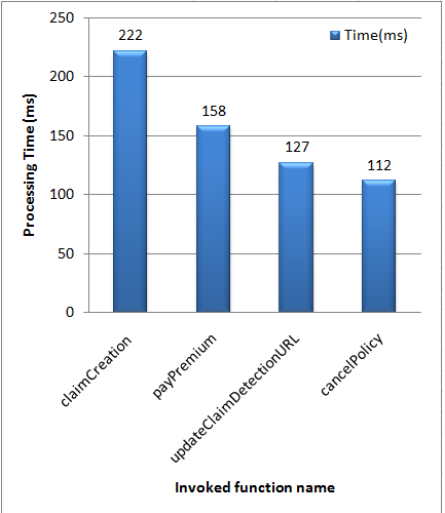
Figure 3. Computational cost for one insured’s insurance policy.